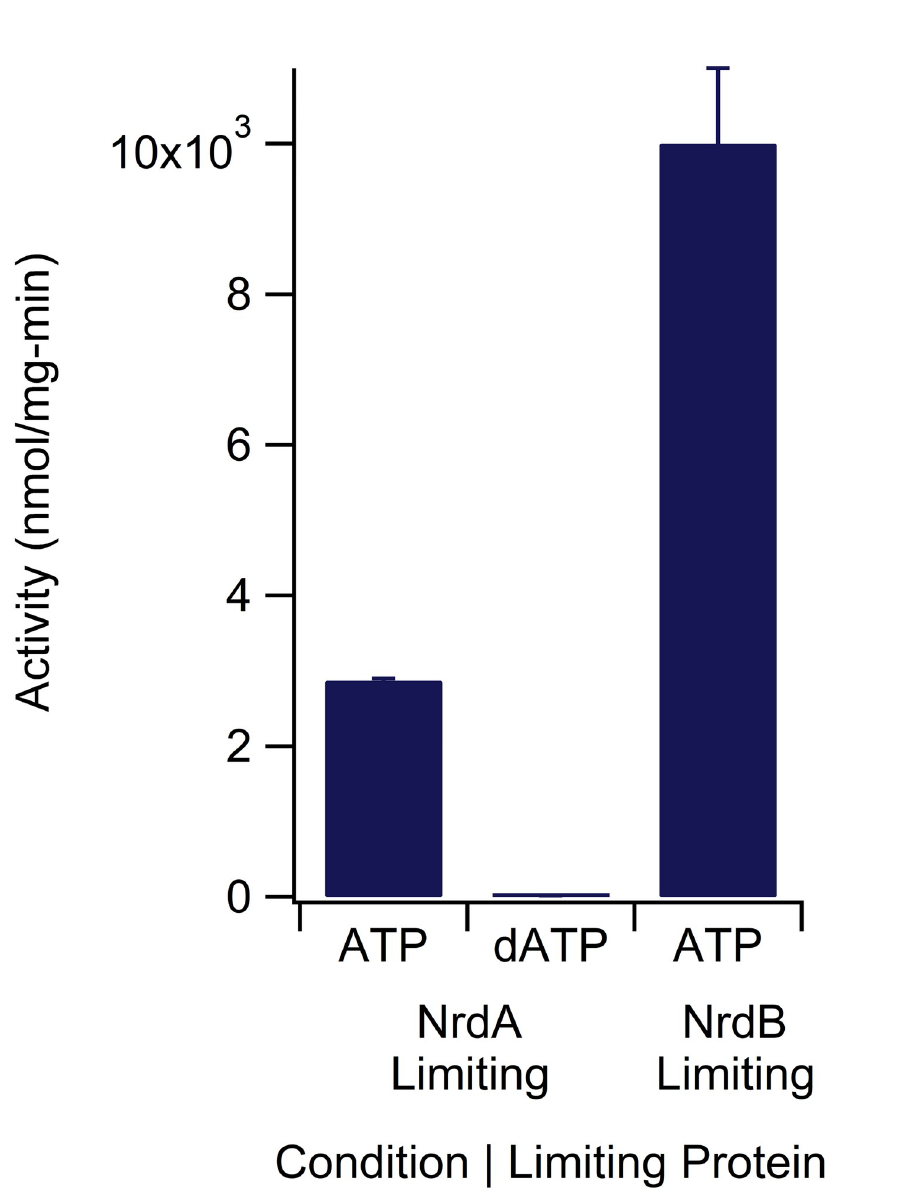
Fig 4. Activity of E . coli class Ia ribonucleotide reductase. Each bar represents average activity +/- standard error of the mean for three replicates. NrdA ATP and dATP conditions had 0.1 μ M NrdA and 0.5 μ M NrdB and 3000 μ M ATP or 0.175 μ M dATP, respectively, whereas the NrdB condition had 3000 μ M ATP, 0.1 μ M NrdB, and 0.5 μ M NrdA. All conditions contained CDP (1000 μ M), Trx (30 μ M), TrxR (0.5 μ M), and NADPH (200 μ M). All protein concentrations are expressed as concentration of the